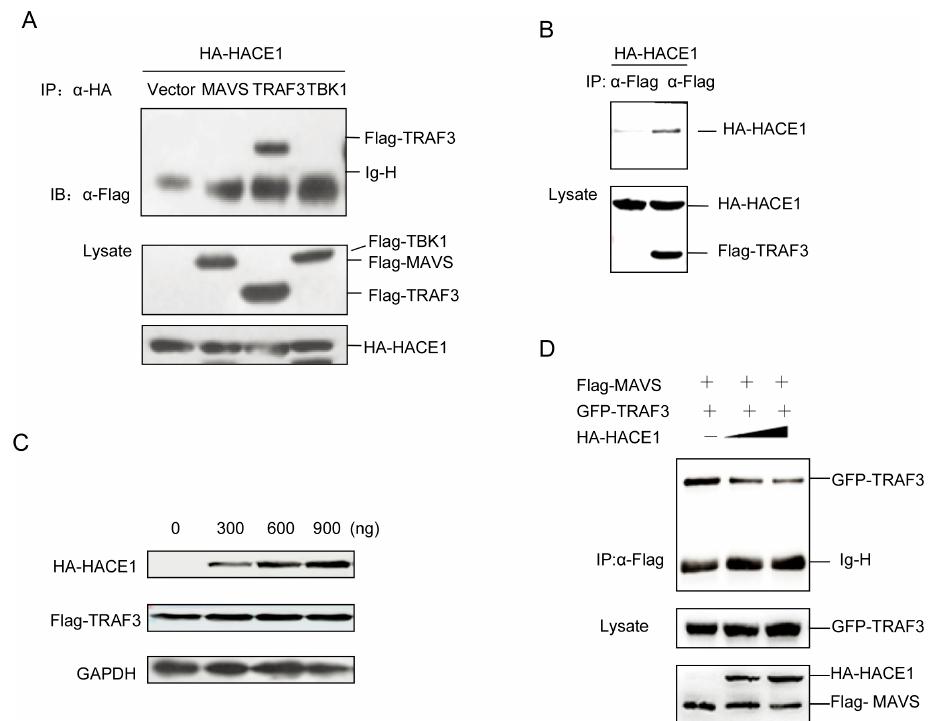
Figure 5. HACE1 impedes the formation of the MAVS-TRAF3 complex. ( A , B ) HACE1 interacted with TRAF3 in a mammalian overexpression system. HEK293T cells were transfected with the mock control, Flag-tagged MAVS, Flag-tagged TRAF3 or Flag-tagged TBK1 and HA-tagged HACE1. Co-immunoprecipitation was performed with indicated antibodies, and then, the membrane was blotted with anti-Flag or anti-HA Ab; ( C ) HACE1 did not promote the degradation of TRAF3. HEK293T cells were coexpressed with Flag-tagged TRAF3 and increasing amounts of HA-tagged HACE1. Twenty-four hours after transfection, the cells were harvested and detected by Western blot. ( D ) HACE1 disrupts the MAVS-TRAF3 complex. HEK293 cells were transfected with Flag-MAVS and GFP-TRAF3 with an increasing amount of HA-HACE1. Flag-MAVS was immunoprecipitated, and the membrane was immunoblotted with anti-GFP antibody. Data are representative of at least three independent experiments.